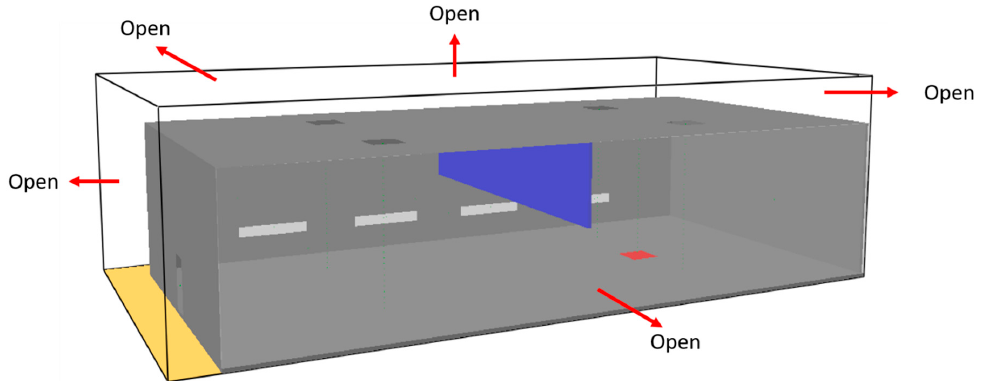
Figure 3. Boundary conditions used in the numerical simulation.